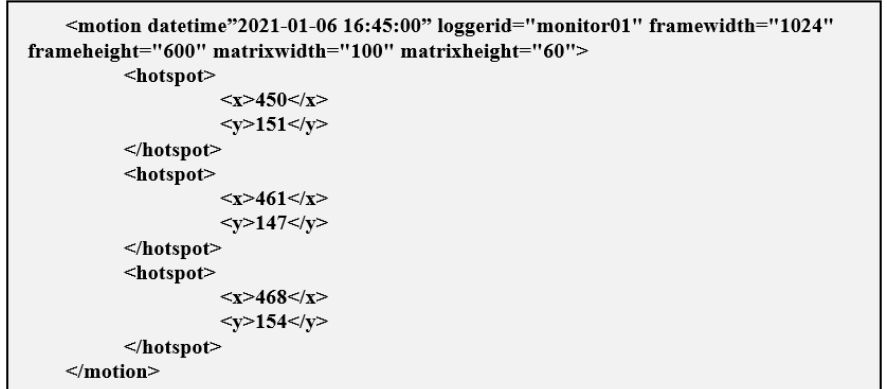
Figure 12. Example of an XML message used.